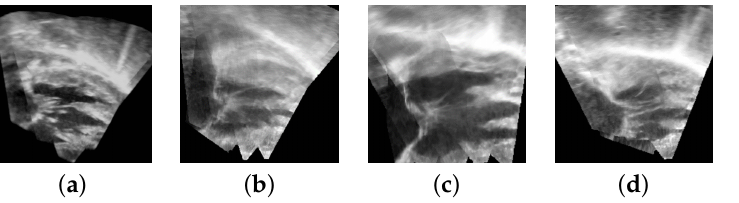
Figure 4. Results of blending functions max ( a ), average ( b ), distance weighted ( c ), and oriented symmetry plus distance weighted ( d ).